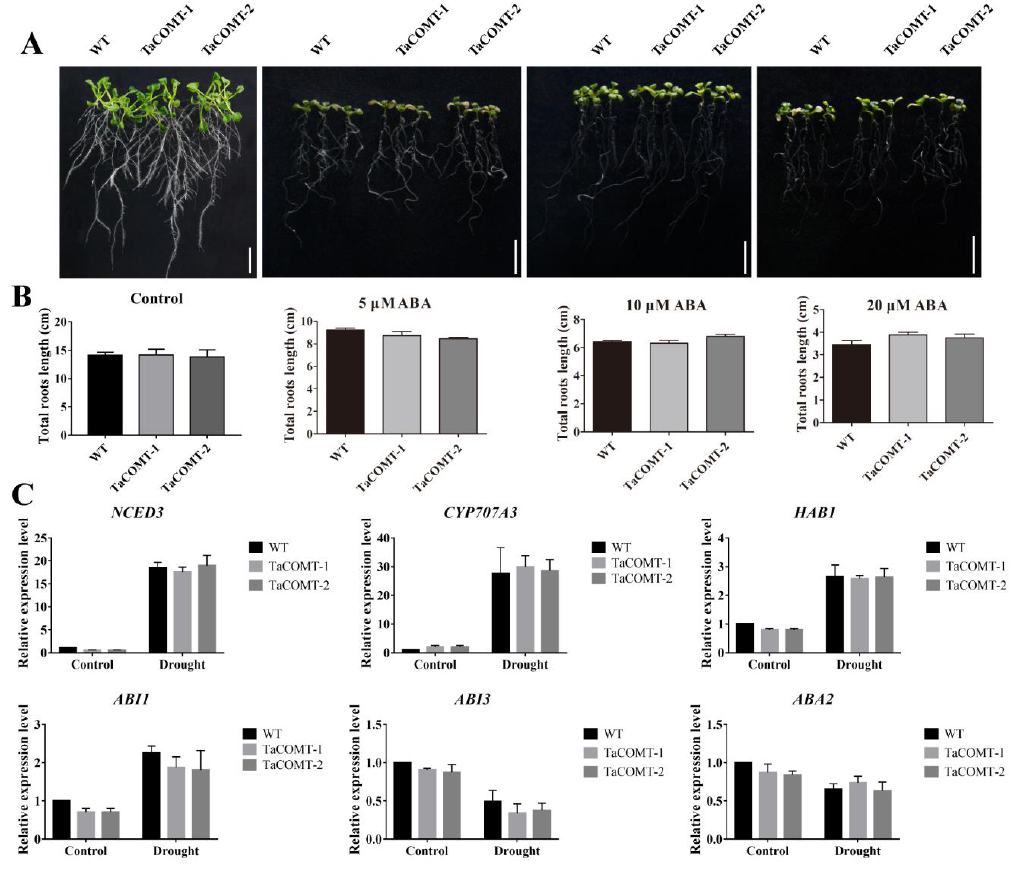
Figure 6. The root length of ABA treatment and expression level of ABA-responsive genes in transgenic lines. The six-day-old seedlings of WT and TaCOMT transgenic lines were transferred to ½ MS medium containing 0, 5, 10 and 20 µM ABA. A week later, the phenotype of roots was investigated (bar = 2 cm) ( A ). The total root length of WT and transgenic lines were statistically analysis ( B ) For the expression level of ABA-responsive genes, two-week-old Arabidopsis seedlings were placed on filter paper for two hours to simulate drought, and then the transcription level of ABA-responsive genes was analyzed ( C ). Expression of AtActin as a loading control. At least 25 seedlings per phenotype were counted. The data are shown as the means ± SDs ( n = 25) of three experiments. ANOVA test demonstrated significant differences (* p < 0.05, ** p <